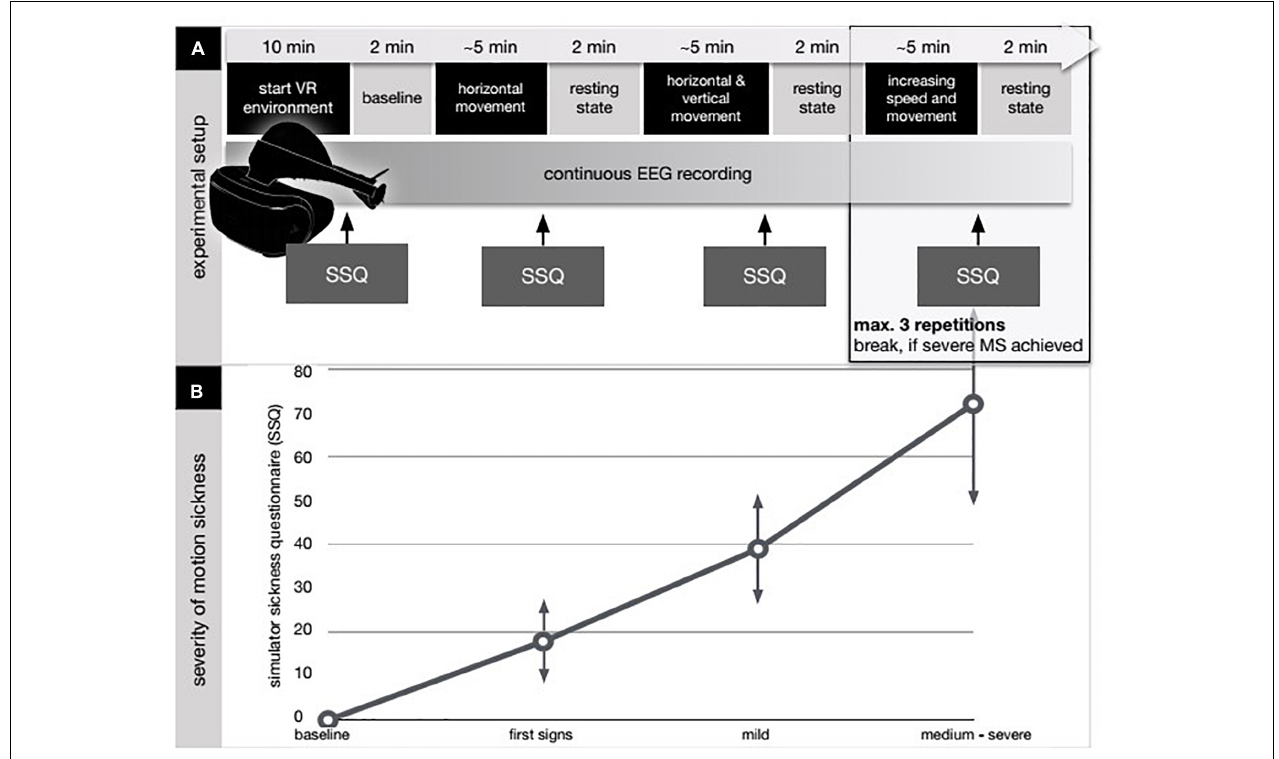
FIGURE 1 | Experimental design and results from the simulator sickness questionnaire (SSQ). (A) After applying the EEG cap, the VR device as a head-mounted display was attached and the subjects entered the VR environment (VRE). The first 10 (2 × 5) minutes were spent by getting to know the VRE and the used avatar in the VRE (start VR environment). No EEG was recorded at this point. In the first 5 min the subjects were asked to move their head and their upper body to get used to the environment. In the following 5 min the subjects were not allowed to move while no external movement was applied either thus not to induce motion sickness before the start of the intervention. Next step was to determine a baseline EEG-condition. To achieve this the subjects had to hold still and close their eyes for 2 min (baseline) while EEG was recorded. Afterward, continuous EEG-recording was initiated and the avatar within the VRE was externally moved (movement period). Movement speed and freedom were increased step by step according to a predefined protocol. The subjects had no influence on the movement of their avatar and thus their experienced visual input as they were not allowed to move. After 5 min of movement a resting-state period took place in which the subjects had to hold still and close their eyes for 2 min (resting-state period). After each resting-state period subjects were queried according to the simulator sickness questionnaire (SSQ) for the appearance of sickness-related feelings (Kennedy et al., 1992, 1993; Biernacki et al., 2016; Bimberg et al., 2020). (B) Individual results in the SSQ are shown in the bottom diagram. In the baseline condition, the subjects had finished 10 min of habituation in the VR environment. First signs refer to the report of first symptoms after the first movement period. In the mild MS, the subjects reported a beginning discomfort without any signs of dizziness, vomiting, or vegetative agitation (SSQ below 50). Occurrence of those symptoms combined with a SSQ score above 50 was grouped and labeled as medium/severe